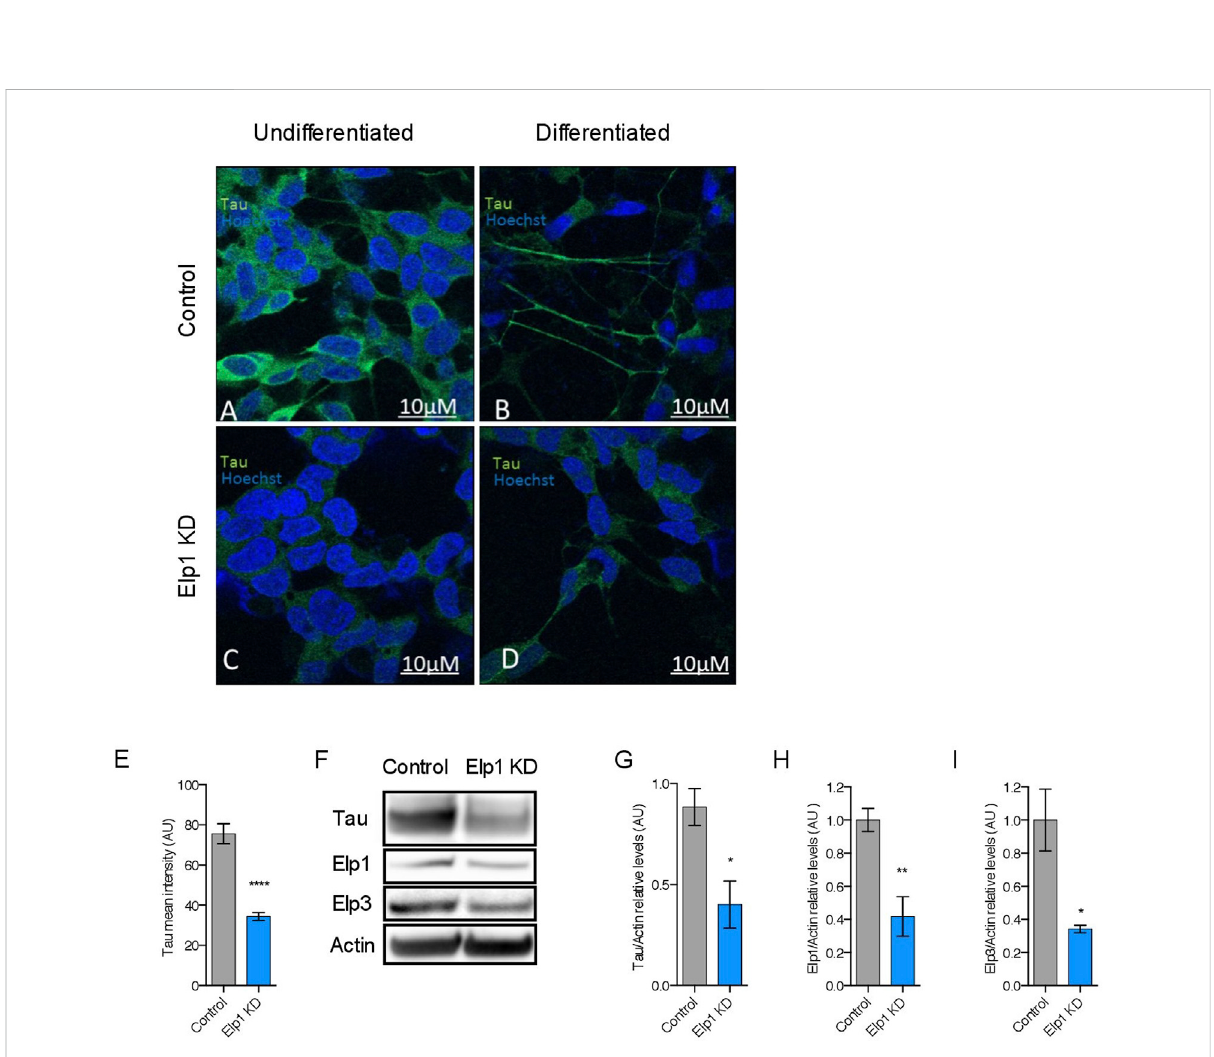
FIGURE 2 Elongator depletion leads to reduction in Tau protein expression. (A – E) Immunolabeling and quanti fi cation of Tau in Elp1 KD and control SHSY5Ycells.Tauisstainedingreen,before (A,C) andafterdifferentiation (B,D) .Scalebaris10 µm. (F – I) WesternblottingtodetectandquantifyTau, Elp1, Elp3 and ß-Actin in differentiated SHSY5Y extracts from Control and Elp1 KD cells. Histograms of proportion of Tau (G) , Elp1 (H) and Elp3 (I) expression to ß-Actin. All graphs show values of means ± SEM. Signi fi cance was determined by: eg-i two-sided t test, Speci fi cally, [ (E) p < 0.0001; (G) p = 0.0114; (H) p = 0.0018; (I) p = 0.0249; ]. n = Number of wells (each well contains data from 20 fi elds, each fi eld contains hundreds of cells): (E) Control n = 119; Elp1 KD n = 85; n = Number of experimental repeats: (G) Control n = 5; Elp1 KD n = 5; (H) Control n = 6; Elp1 KD n = 6; (I) Control n = 3; Elp1 KD n =